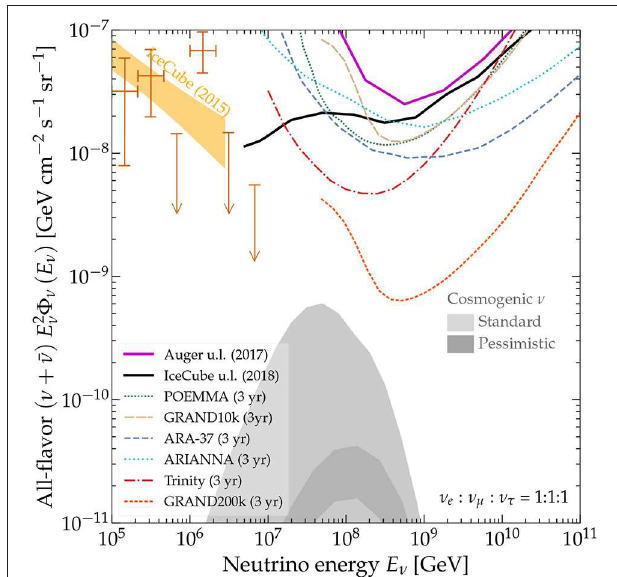
FIGURE 17 | Predicted fluxes of cosmogenic neutrinos and expected sensitivities of current, upcoming and proposed UHECR and UHE neutrino experiments. Upper limits are from IceCube ( Aartsen et al., 2018) and the Pierre Auger Observatory (Bellido, 2018). Sensitivities are for POEMMA (Olinto et al., 2018 ) (assuming full-sky coverage), GRAND in its 10,000-antenna (GRAND10k) and 200,000-antenna configurations (GRAND200k) Alvarez-Muniz et al. (2018), ARA-37 (Allison et al., 2016) (trigger level), ARIANNA (Persichilli, 2018) (“optimal wind” sensitivity), and Trinity (Otte, 2018) (10 m 2 mirror). M. Bustamante for this